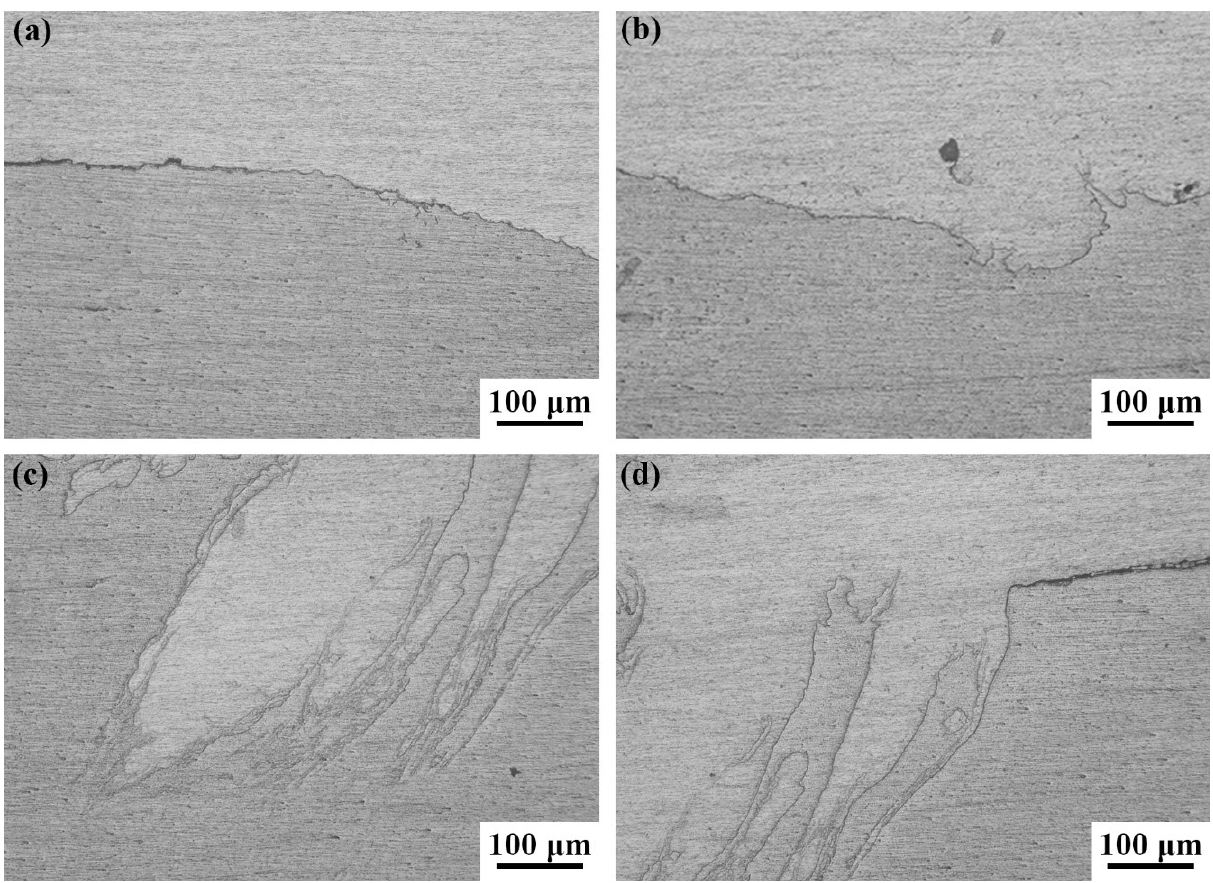
Figure 6: Magnified morphologies of (a) region B, (b) region C, (c) region D, and (d) region E in Figure 5(a).